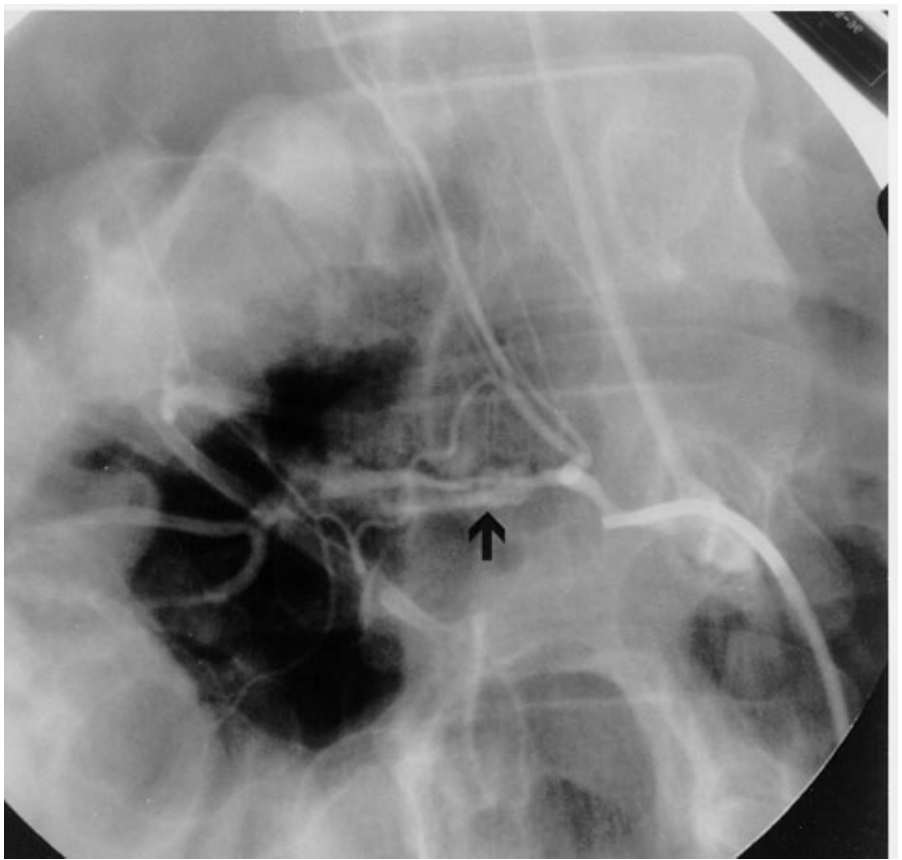
FIGURE 2. Right renal arteriogram. Arrow denotes area of dissection with